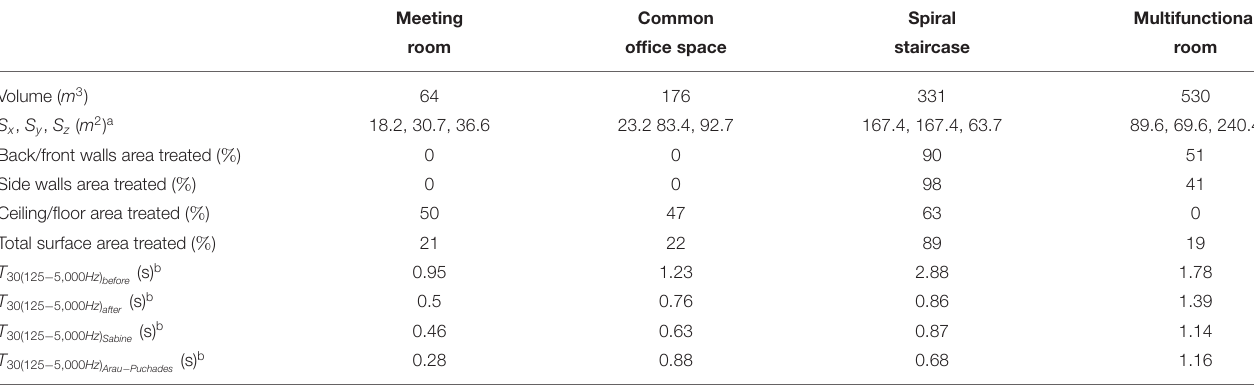
TABLE 3 | Summary of room dimensions, acoustically treated surfaces, and average reverberation time before and after the installation of acoustic